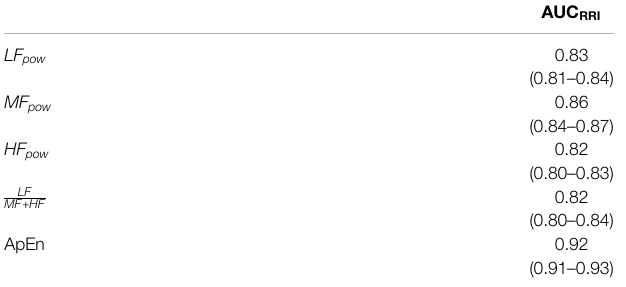
TABLE 2 | Median AUC RRI and 95% con fi dence intervals.